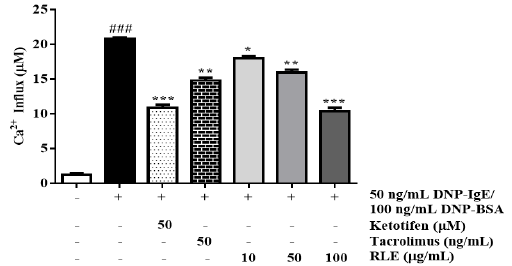
Figure 6. The effects of R. davurica Pall. leaf extract on Ca 2+ influx from RBL ‐ 2H3 cells. Data are presented as the mean ± SD. * indicate significant differences between the non ‐ treated cells and DNP ‐ IgE/BSA ‐ sensitized groups, respectively. ### p < 0.001 vs. the non ‐ treated group. *, **and *** p < 0.05, 0.01, and 0.001 vs. the DNP ‐ IgE/BSA ‐ sensitized control, respectively.